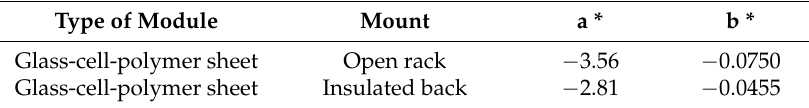
Table 2. Values of the parameters a and b. Data from